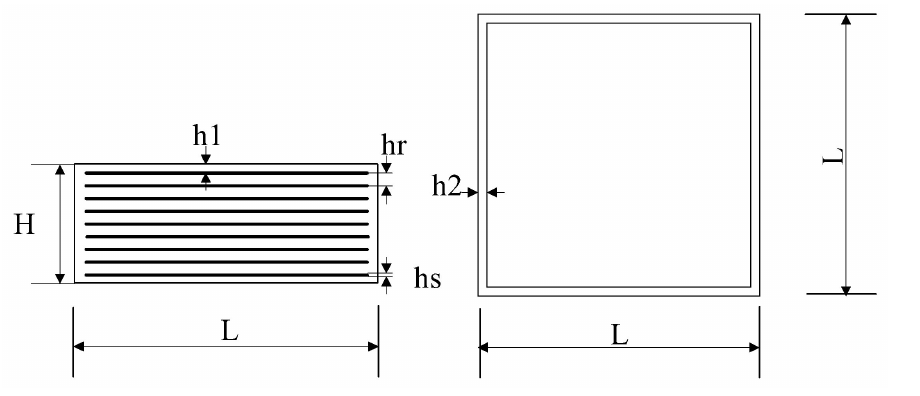
Figure 3. Composition details of the bearing specimens. Table 1. Bearing specimens’ geometry